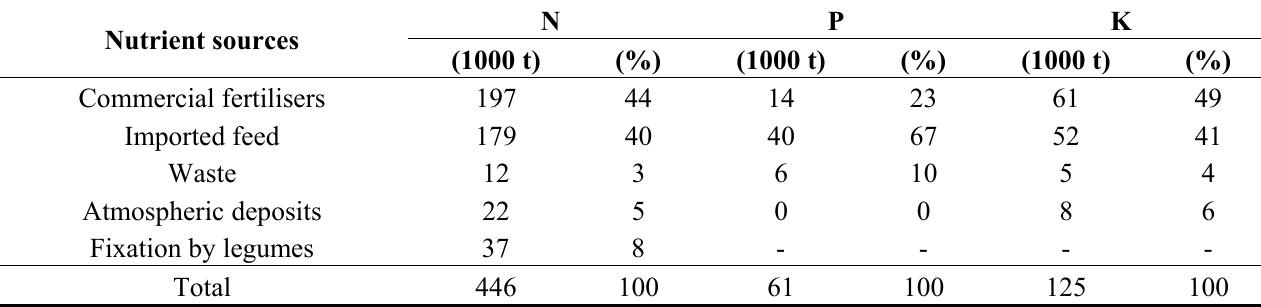
Table 1. Supply of nutrients to Danish agriculture (average 2004–2006) based on Kyllingsbæk